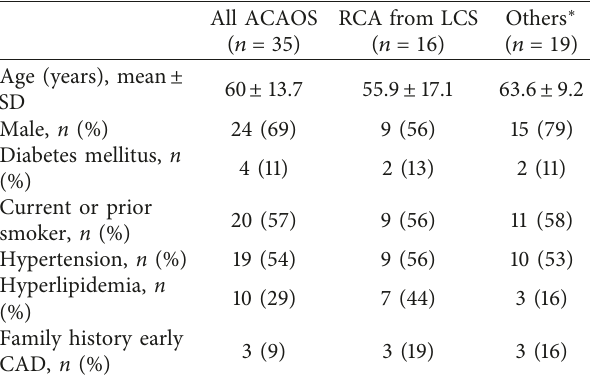
Table 2: Baseline patient